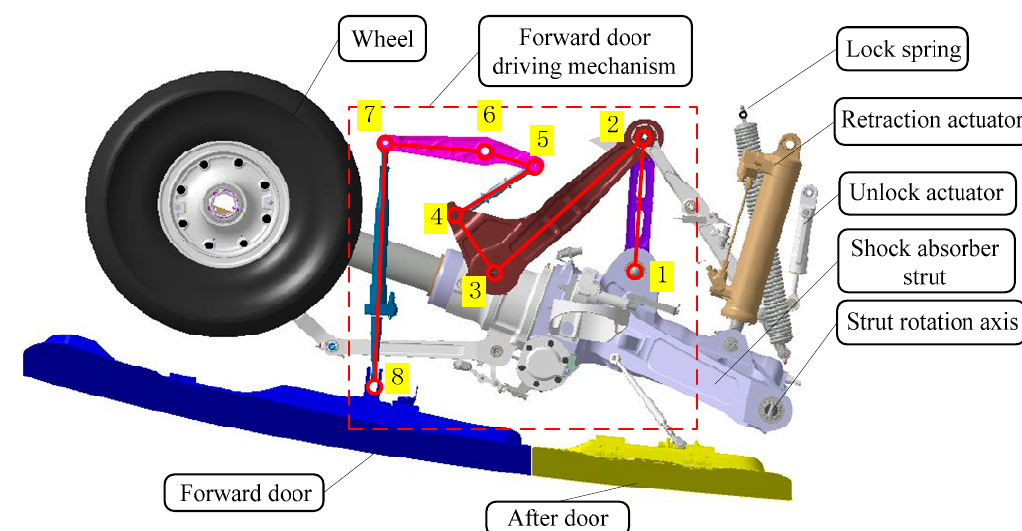
Figure 1. Structure diagraph of emergency extension.